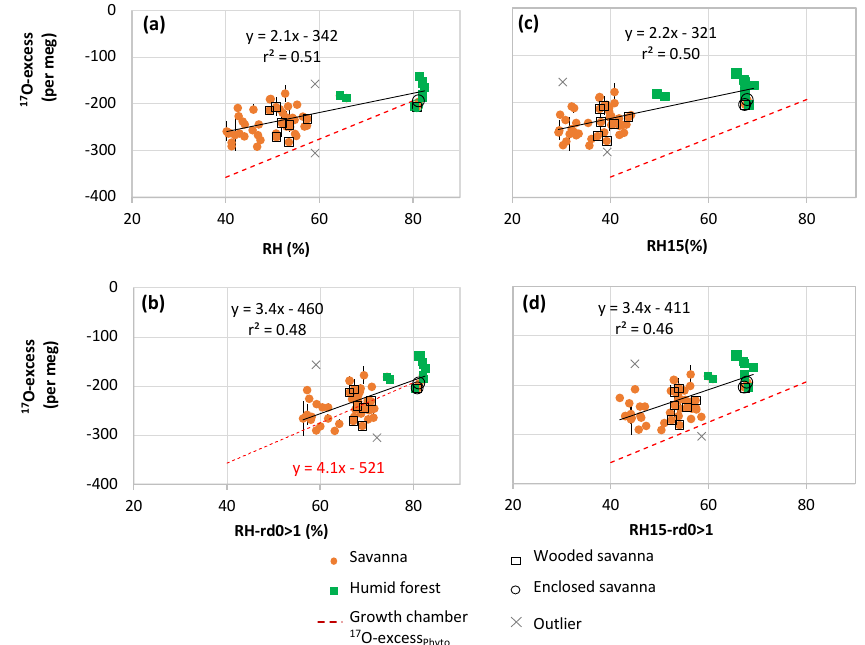
Figure 4. Natural West and Central African transect: 17 O-excess vs. relative humidity (RH) of phytolith assemblages from soil tops col- lected under savanna, wooded savanna, humid forest and enclosed savanna along a humidity gradient (Table 1). The growth chamber 17 O- excess Phyto vs. RH correlation line is displayed for comparison. (a) RH-Av: yearly average of monthly means; (b) RH-rd0>1: yearly average of monthly means for months with at least 1 day with precipitation higher than 0.1mm; (c) RH15: RH at 15:00UTC; (d) RH15-rd0>1: RH- rd0>1 at 15:00UTC.